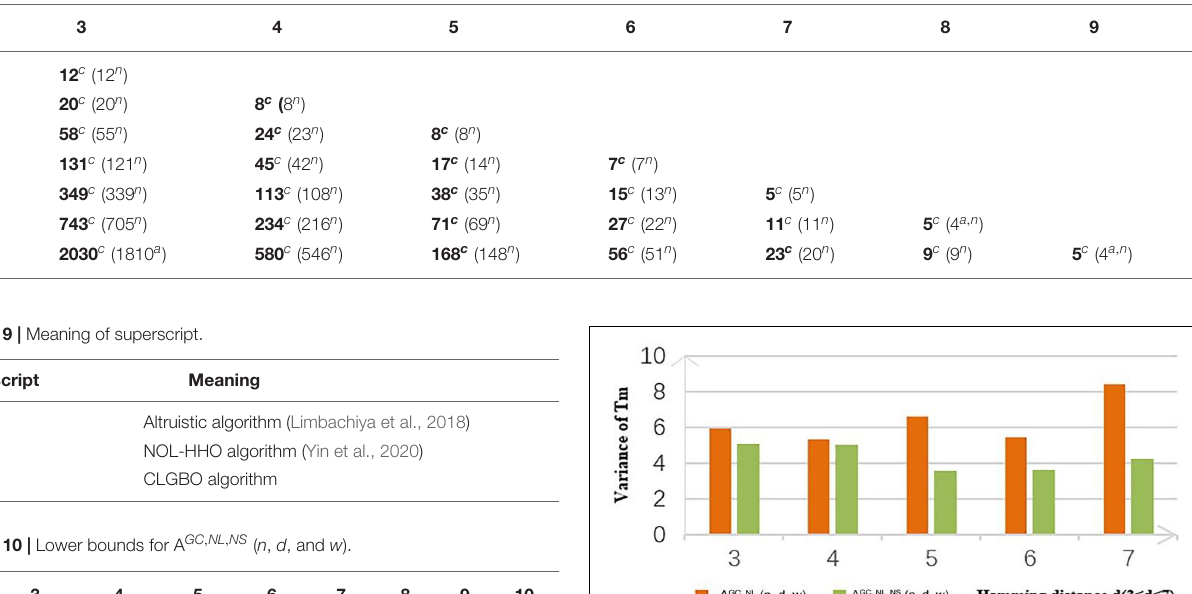
TABLE 8 | Lower bounds of the CLGBO algorithm for A GC , NL ( n , d , and w ).